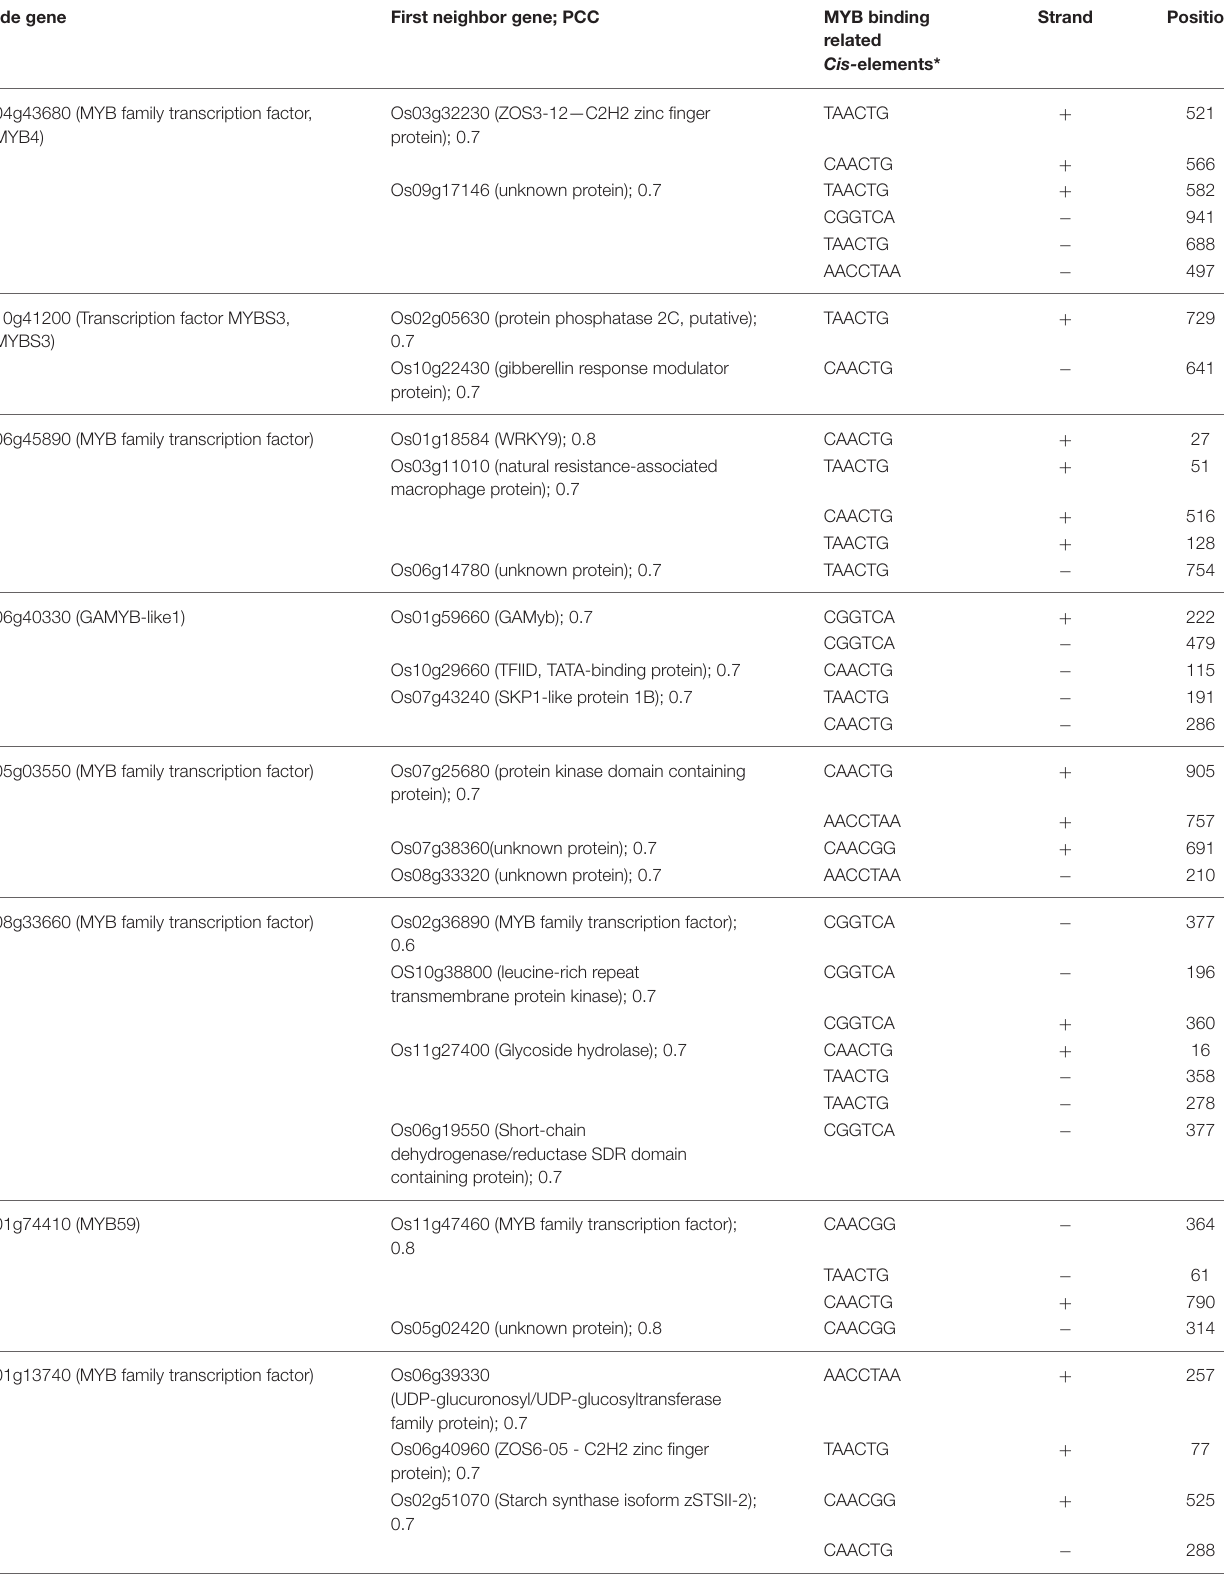
TABLE 2 | The guide OsMYB genes and their first neighbor as putative target with MYB binding cis -elements within 1kb upstream promoter region. Guide